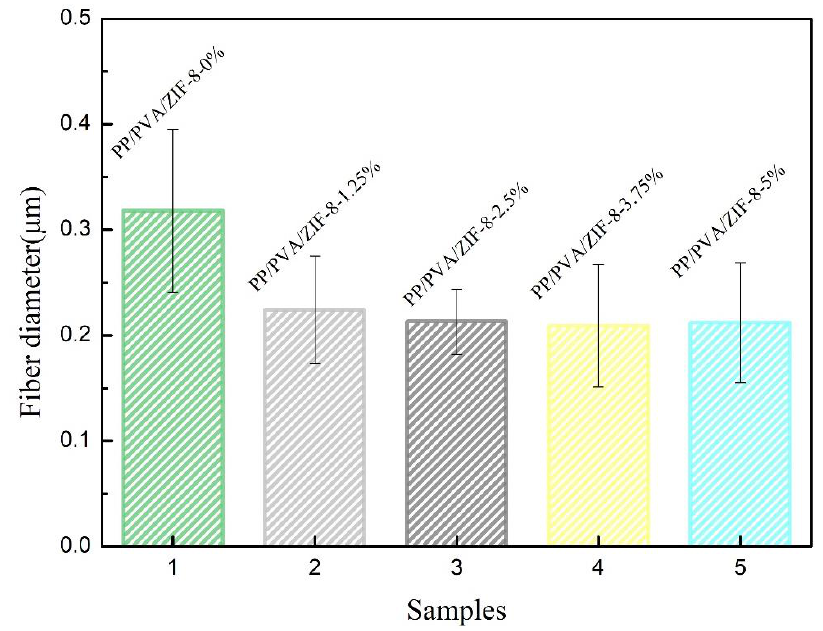
Figure 5. Average fiber diameter of PP melt-blown membranes and PP / PVA / ZIF-8 melt-blown electrospun composite membranes.